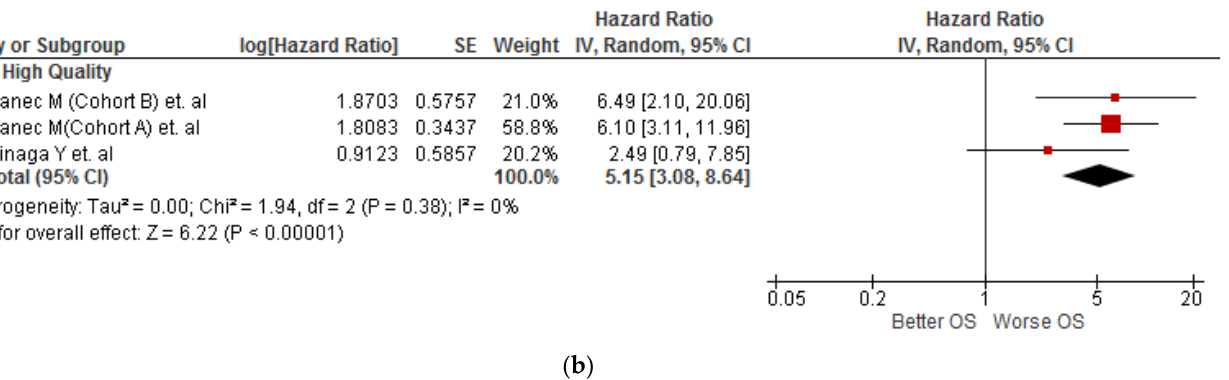
Figure 2. ( a ) Association of SIII values and OS in patients with testicular cancer [23–25]. ( b ) Sensitivity analysis according to the risk of bias of the association between SIII values and OS in patients with testicular cancer [24,25].